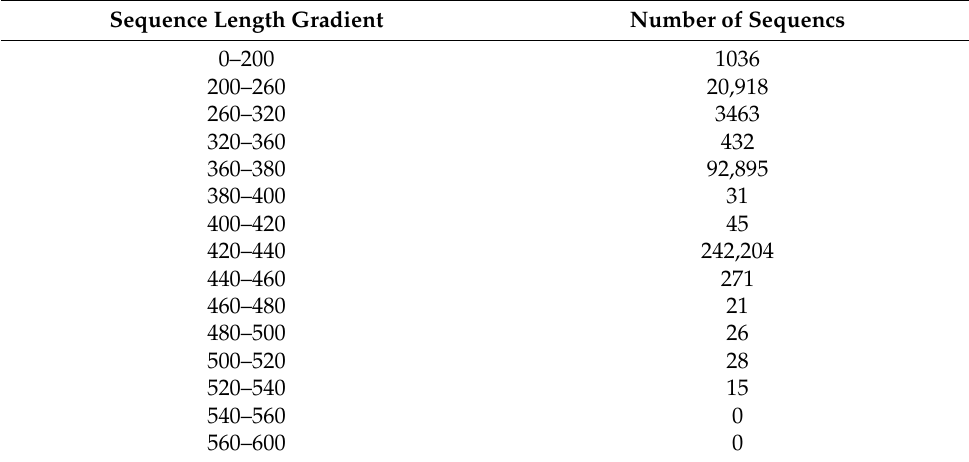
Table 1. Sample sequence length